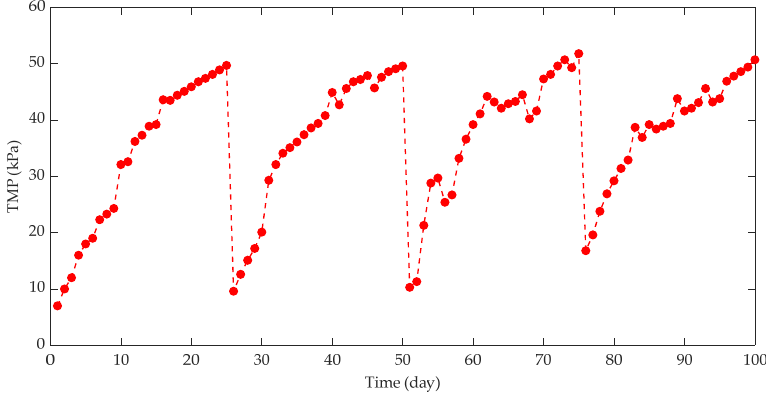
Figure 5. TMP at different hydraulic retention times (HRT). Figure 5. TMP at di ff erent hydraulic retention times